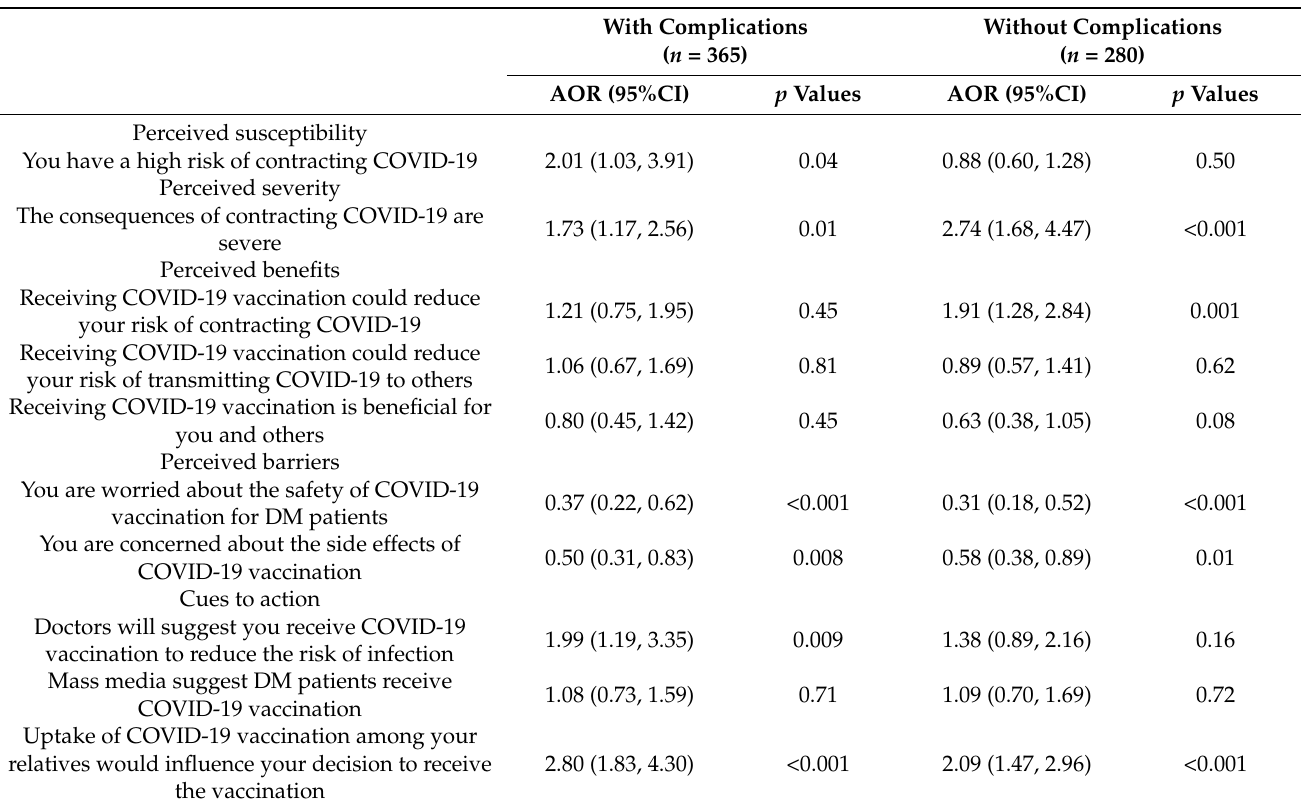
AOR: adjusted odds ratio. Odds ratios adjusted for significant background characteristics listed in Table